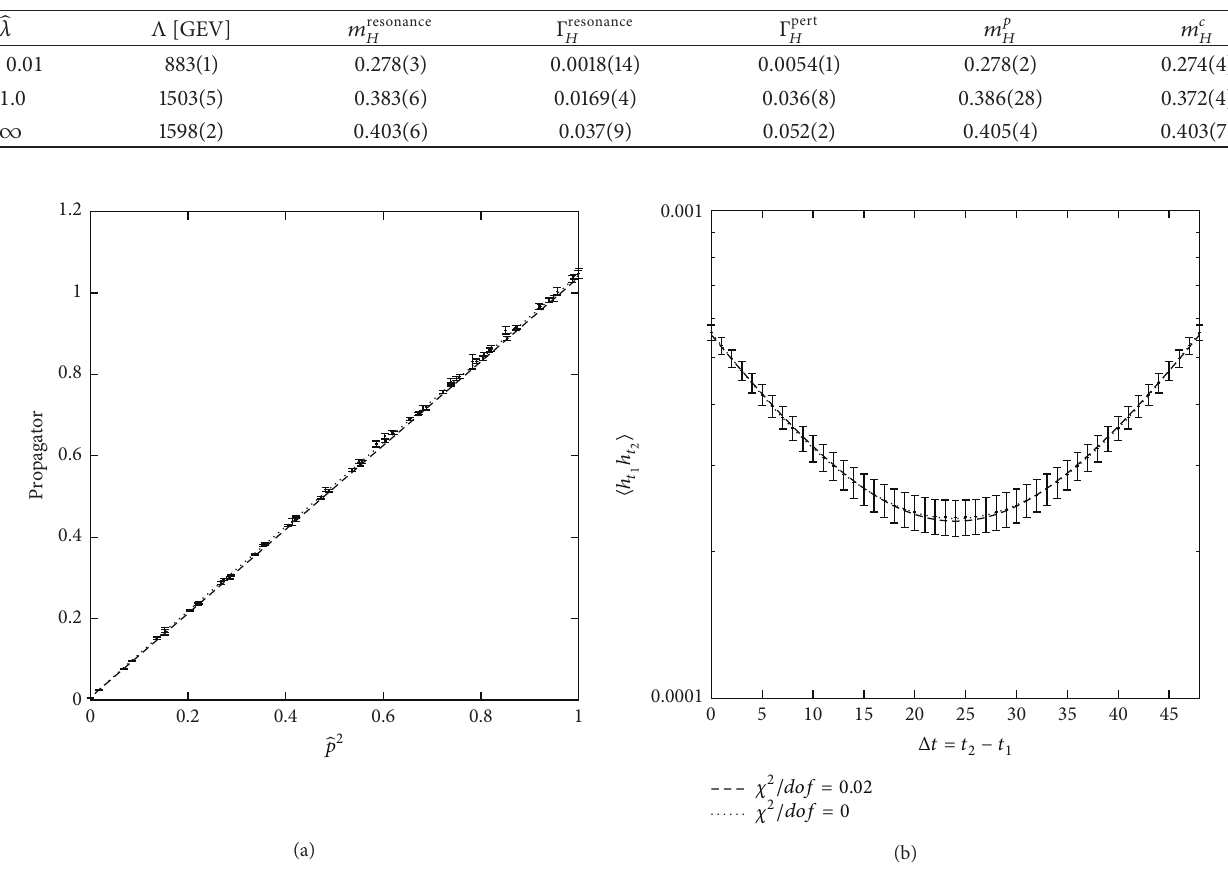
Table 1: The results(taken from[29])of a study comparing theresonance parameters of theHiggs boson with theresultsof fits tothe temporal correlation function and momentum space Higgs boson propagator. Errors are statistical only. Except for the cut-off scale, all the results are in lattice units. The fermion mass is set to be the physical top-quark mass. Results from three values of the quartic coupling are presented. Also shown are the resonance mass and width from Breit-Wigner fits to the scattering cross-section. Finally, a perturbative estimate of the ̂𝜆 = 1.0 is larger than that for the other parameters. resonance width is included. We note that because of some data losses the error on 𝑚 𝑝 𝐻 at